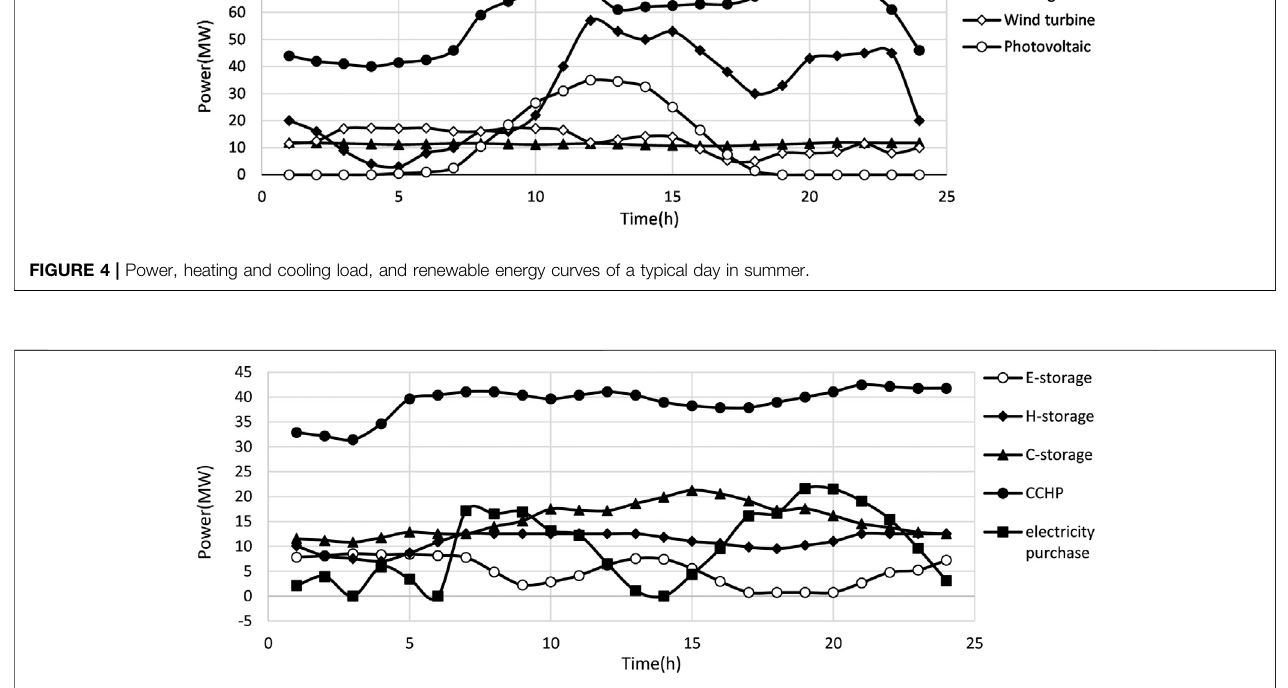
FIGURE 5 | Day-ahead optimization dispatch plan of a typical day in